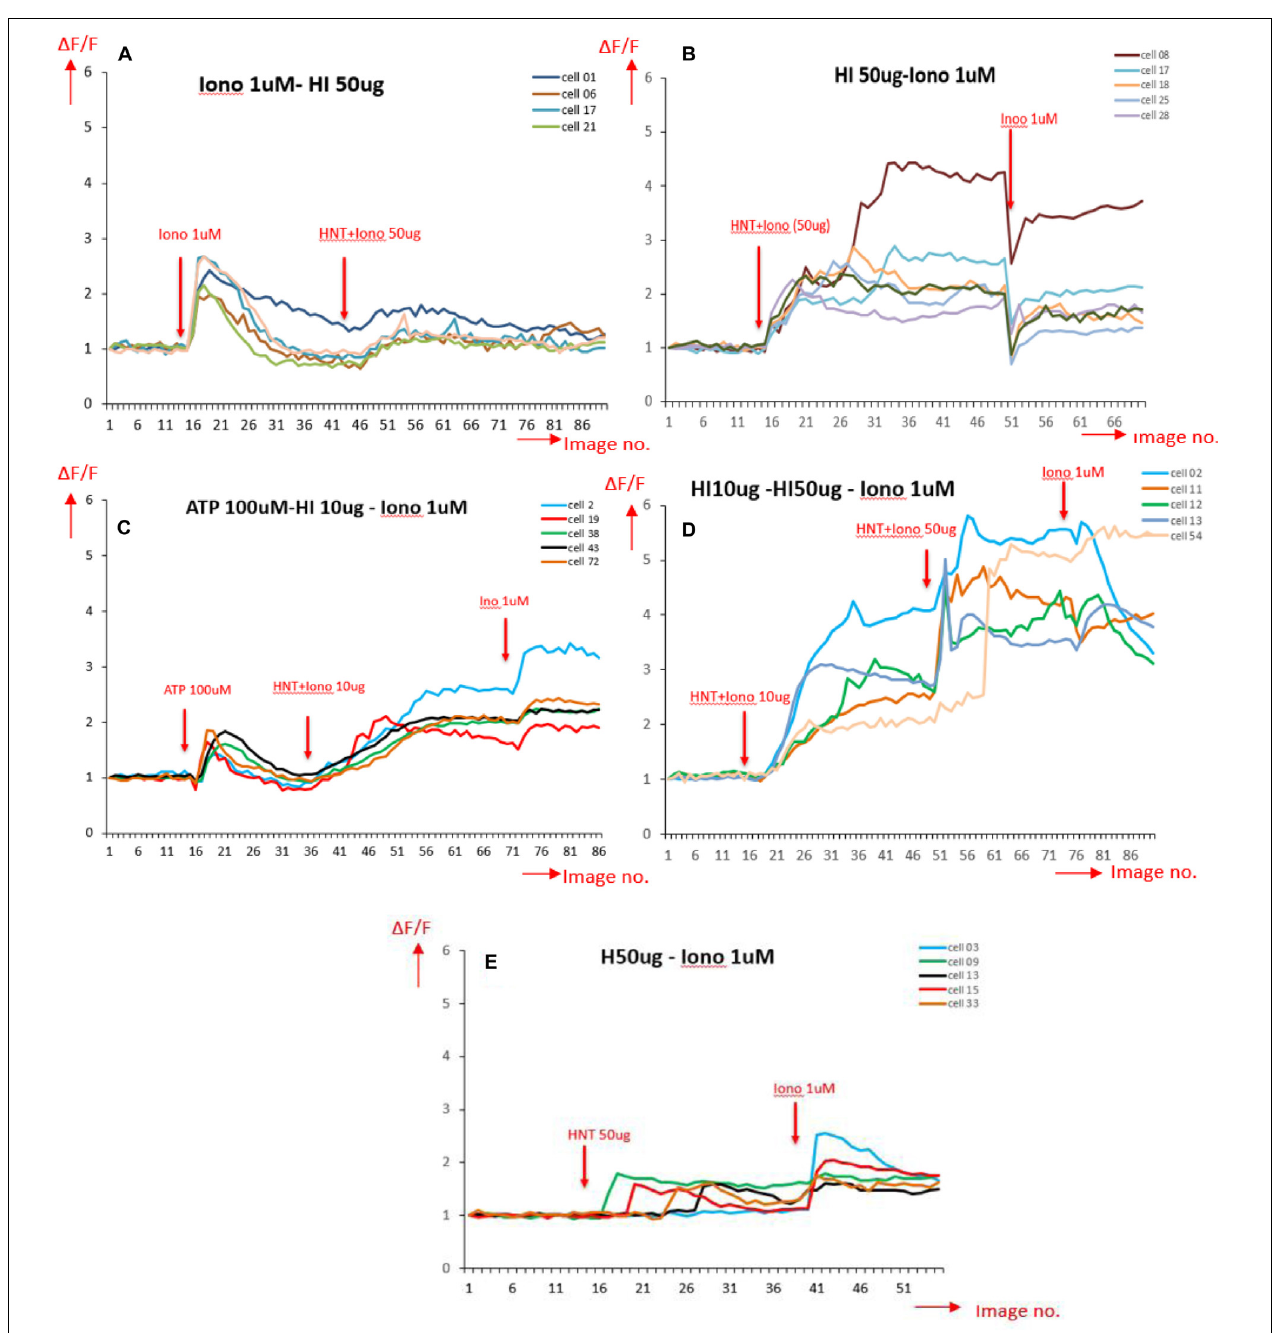
FIGURE 7 | Ca 2 + peak intensity obtained for different stimulation on BMVECs, in the horizontal axis is the image number indicating time periods with total range of 4 s each (1 image no. = 4 s); and in the vertical axis is the normalized values for fluorescence intensity corresponding to calcium activity (A) stimulated by ionomycin (Iono) 1 µ M (positive control); (B) stimulated by 50 µ g/mL HNT- ionomycin (sample tested); (C) stimulated by ATP, a well-known Ca 2 + stimulator (positive control indicating healthy cells), followed by HNT-ionomycin formulation (10 µ g/mL) showing the comparison between the Ca 2 + responses of physiological stimulation (ATP) and HNT-ionomycin formulation for the same cells. (D) Cells stimulated by 10 and 50 µ g/mL of HNT-ionomycin showing comparative results for the cells when stimulated by lower and higher dose of HNT-ionomycin; (E) stimulated by 50 µ g/mL of empty HNTs (negative control).